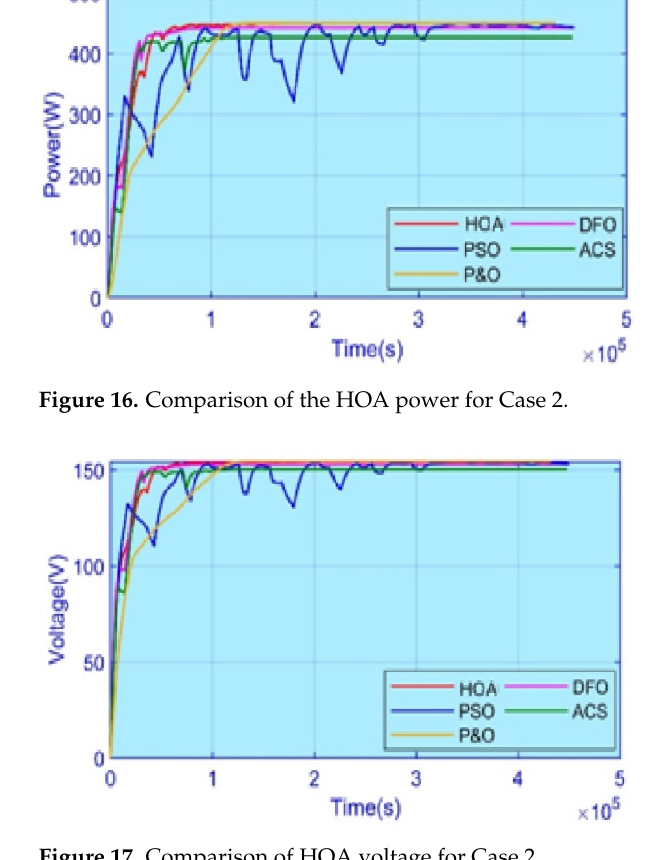
Figure 17. Comparison of HOA voltage for Case 2 .